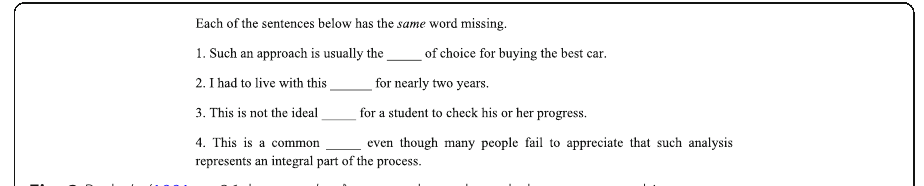
Fig. 2 Butler ’ s (1991, p. 36; key: method ) concordance-based cloze-generated